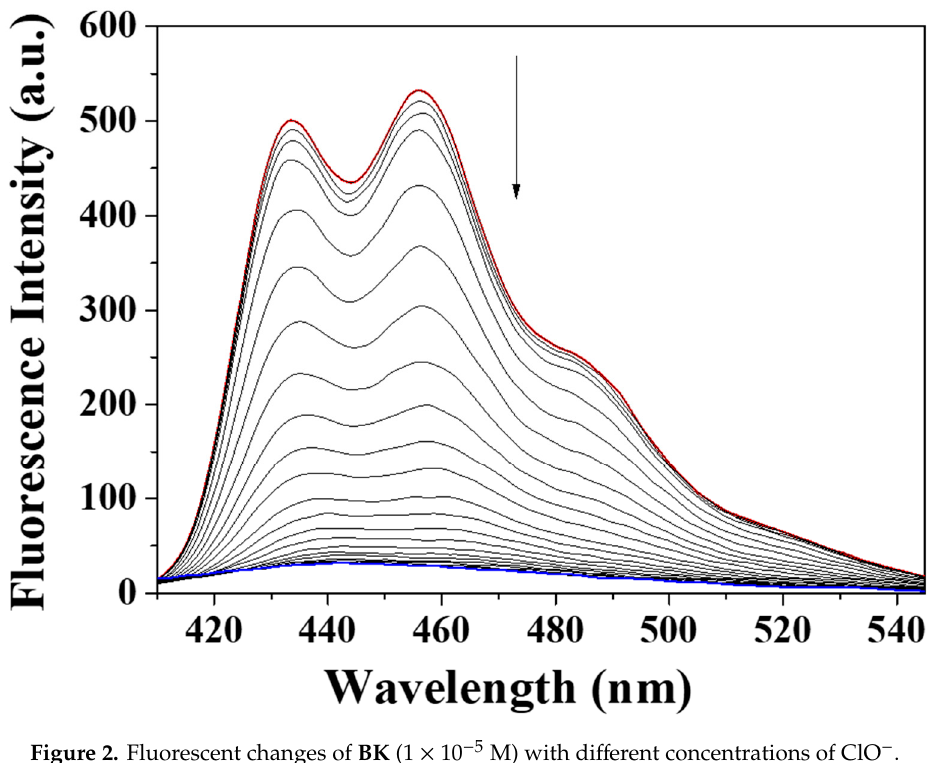
Figure 2. Fluorescent changes of BK (1 × 10 − 5 M) with different concentrations of ClO − .